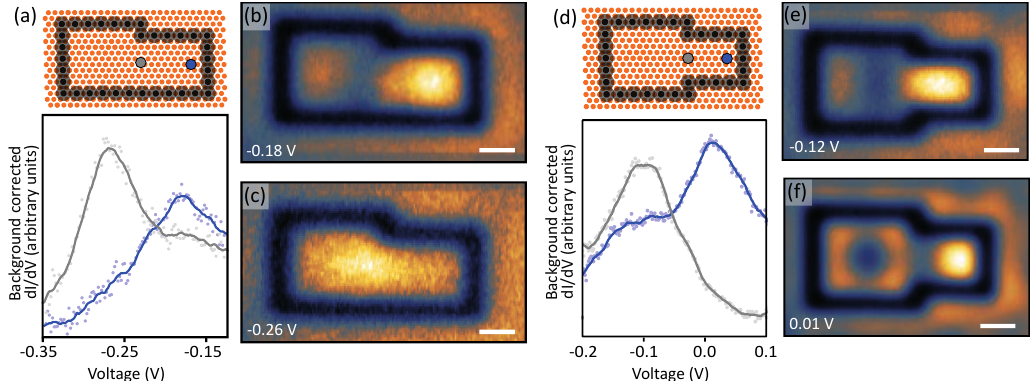
(cid:112) 3 a × 12 a (cid:112) 3 a × 8 a corral. Inset scale